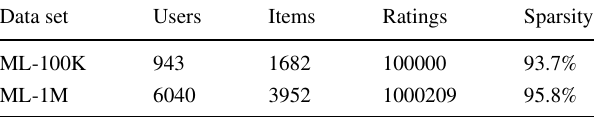
Table 1 Data sets